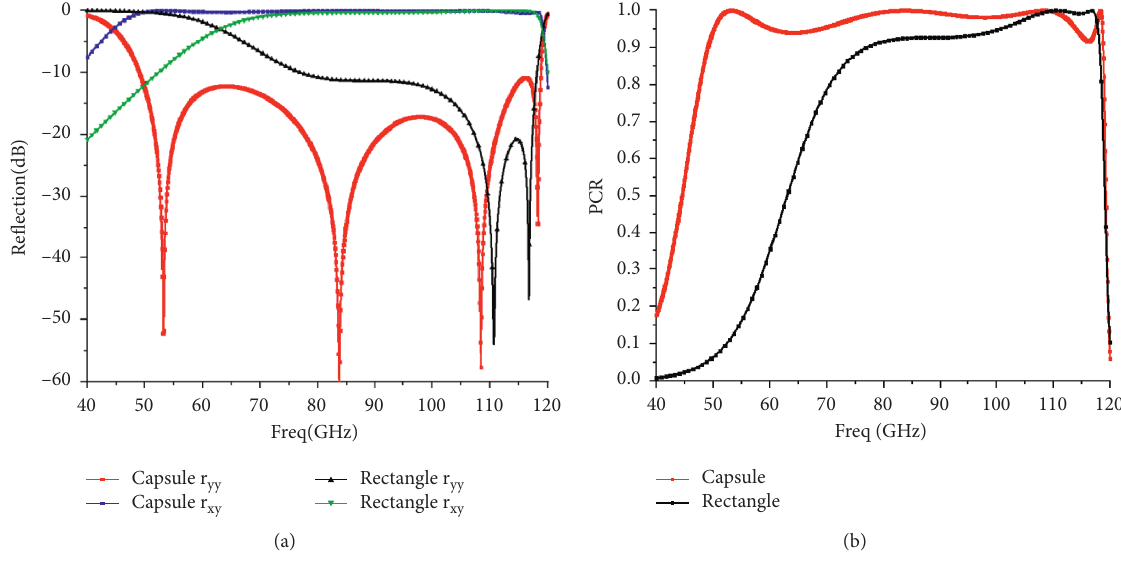
Figure 3: Comparison of capsule and rectangular PCM. (a) Reflection coefficient. (b) PCR.